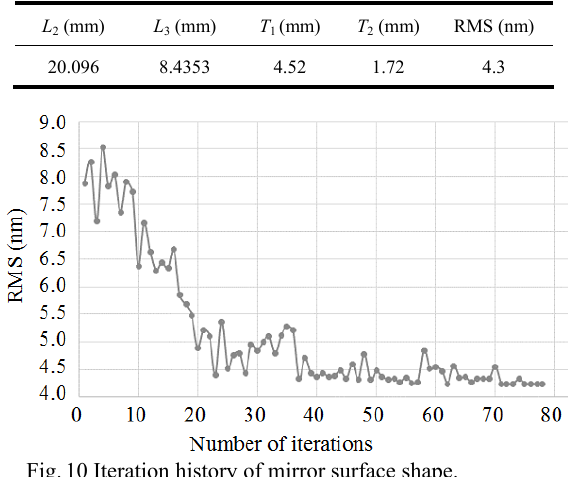
Fig. 10 Iteration history of mirror surface shape.